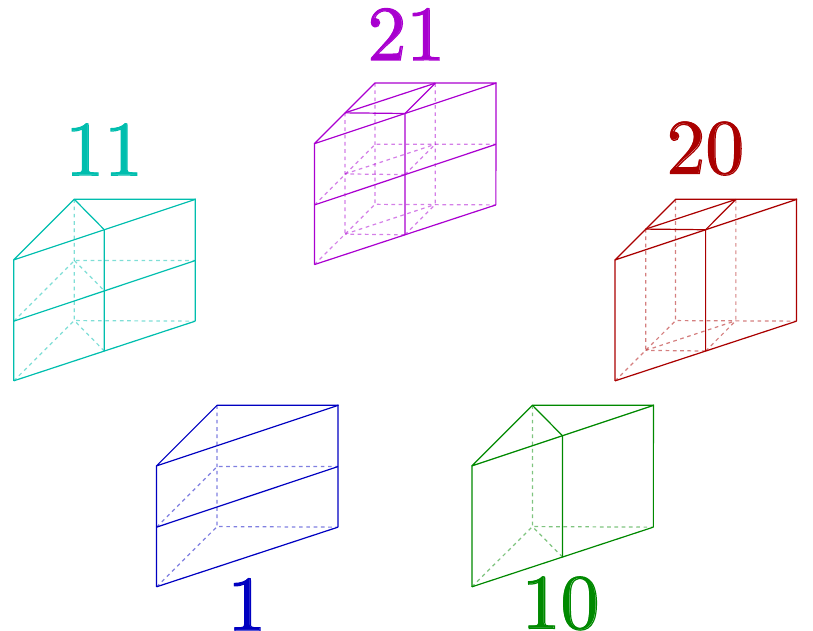
Figure 1. Each possible refinement for triangular prisms. We show for brevity one case out of three for 10 and 11